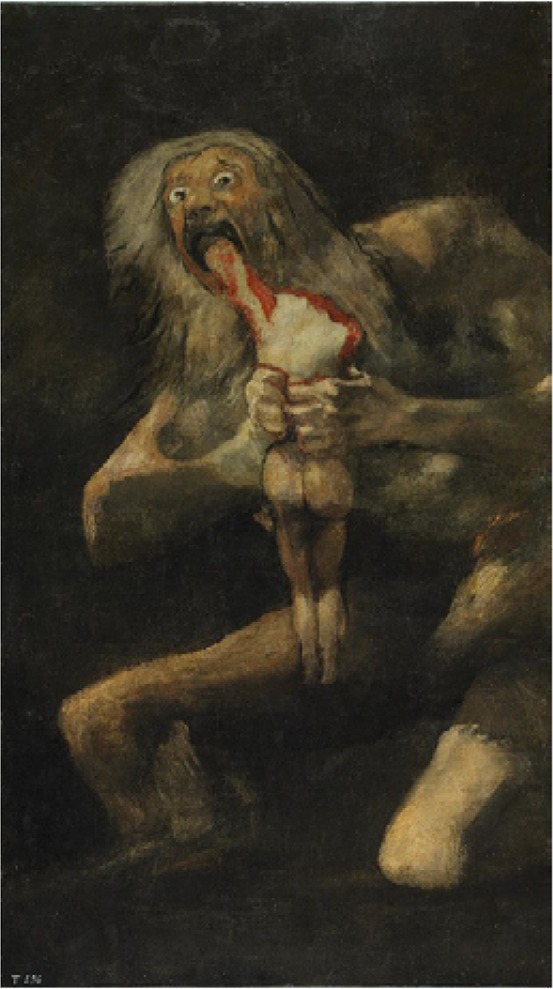
“Saturn Devouring His Son”, Goya, 1819–1823.